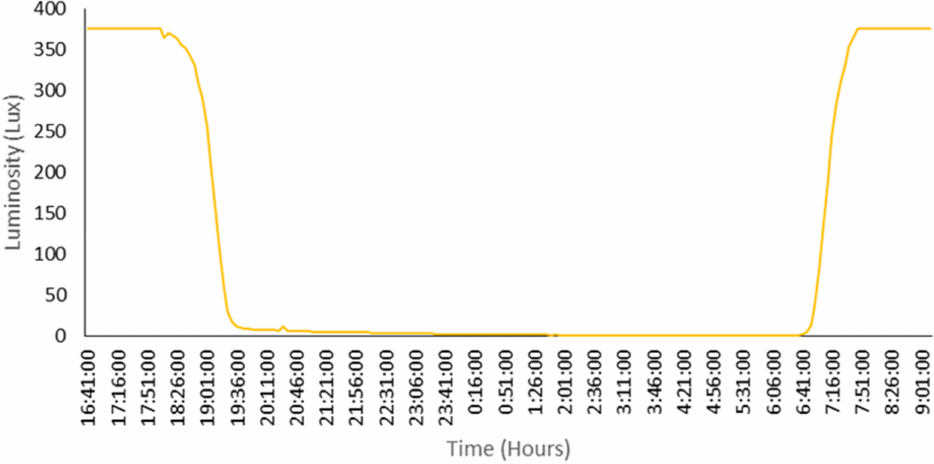
Figure 25. Monitored luminosity throughout the